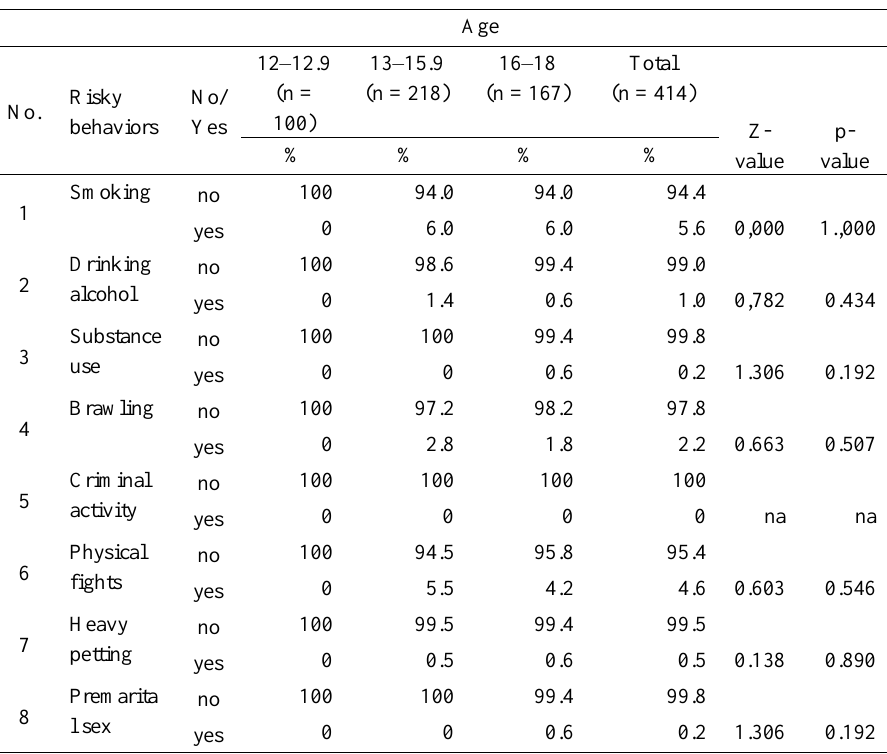
Adolescents’ Risky Behaviors by